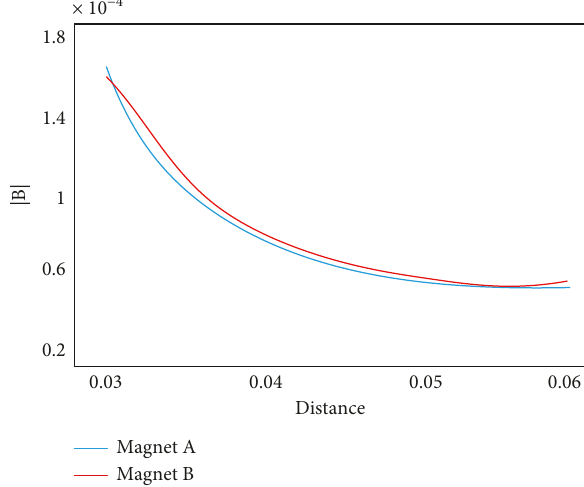
Figure 10: Effect of magnet geometry on distortion.